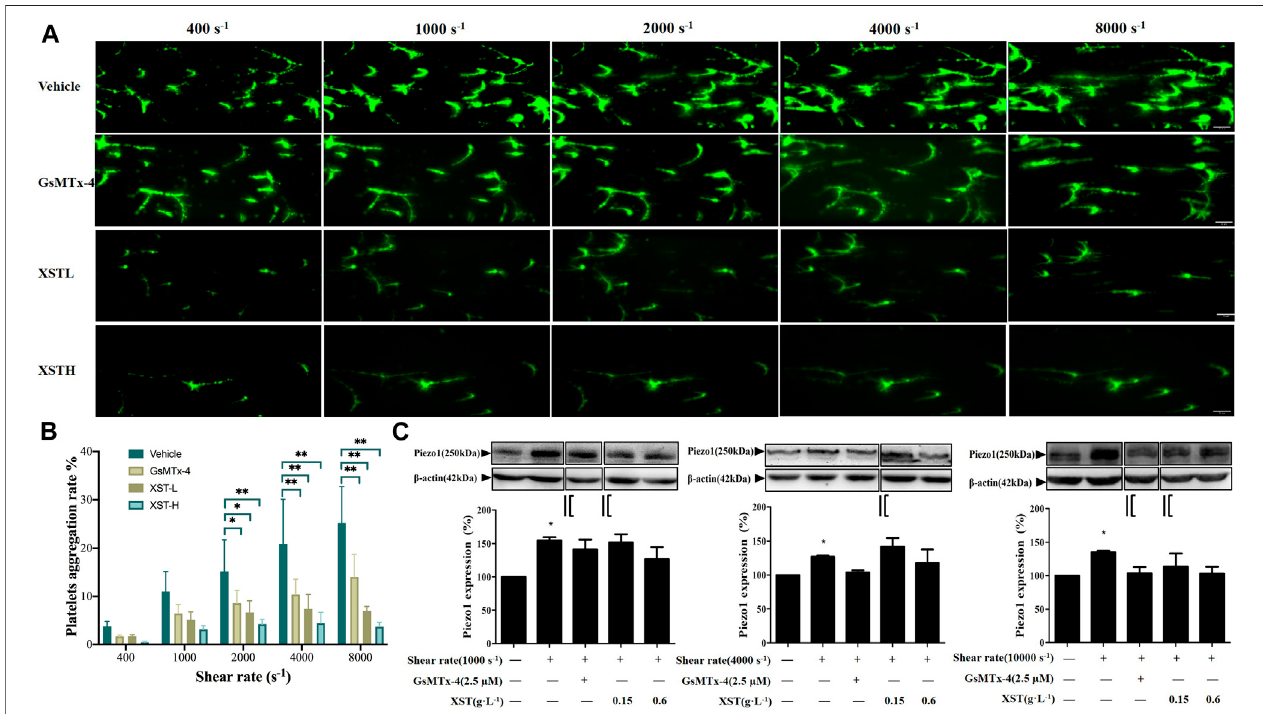
FIGURE 3 | Effects of treatment with XST on shear-induced platelet aggregation. (A) Representative images showing effects of treatment with XST at 0.15 g L − 1 (XSTL) or 0.6 g L − 1 (XSTH) and GsMTx-4 (2.5 µM) on platelet aggregation. The scale bar 50 µm. (B) Mean platelet aggregation rate at the end of exposure to indicated shear rates under the conditions shown in (A) . * p < 0.05 and ** p < 0.01, analyzed by two-way ANOVA and post-hoc Tukey ’ s test. (C) Western blotting analysis of the Piezo1 expression in platelets under static conditions or after exposure to indicated shear alone or together with GsMTx-4 or XST, and the grouping and splicing washighlighted by black lines. Top: representativeblots; bottom: mean data from three independent experiments by one-way ANOVA. * p < 0.05 compared toplatelets under static conditions.